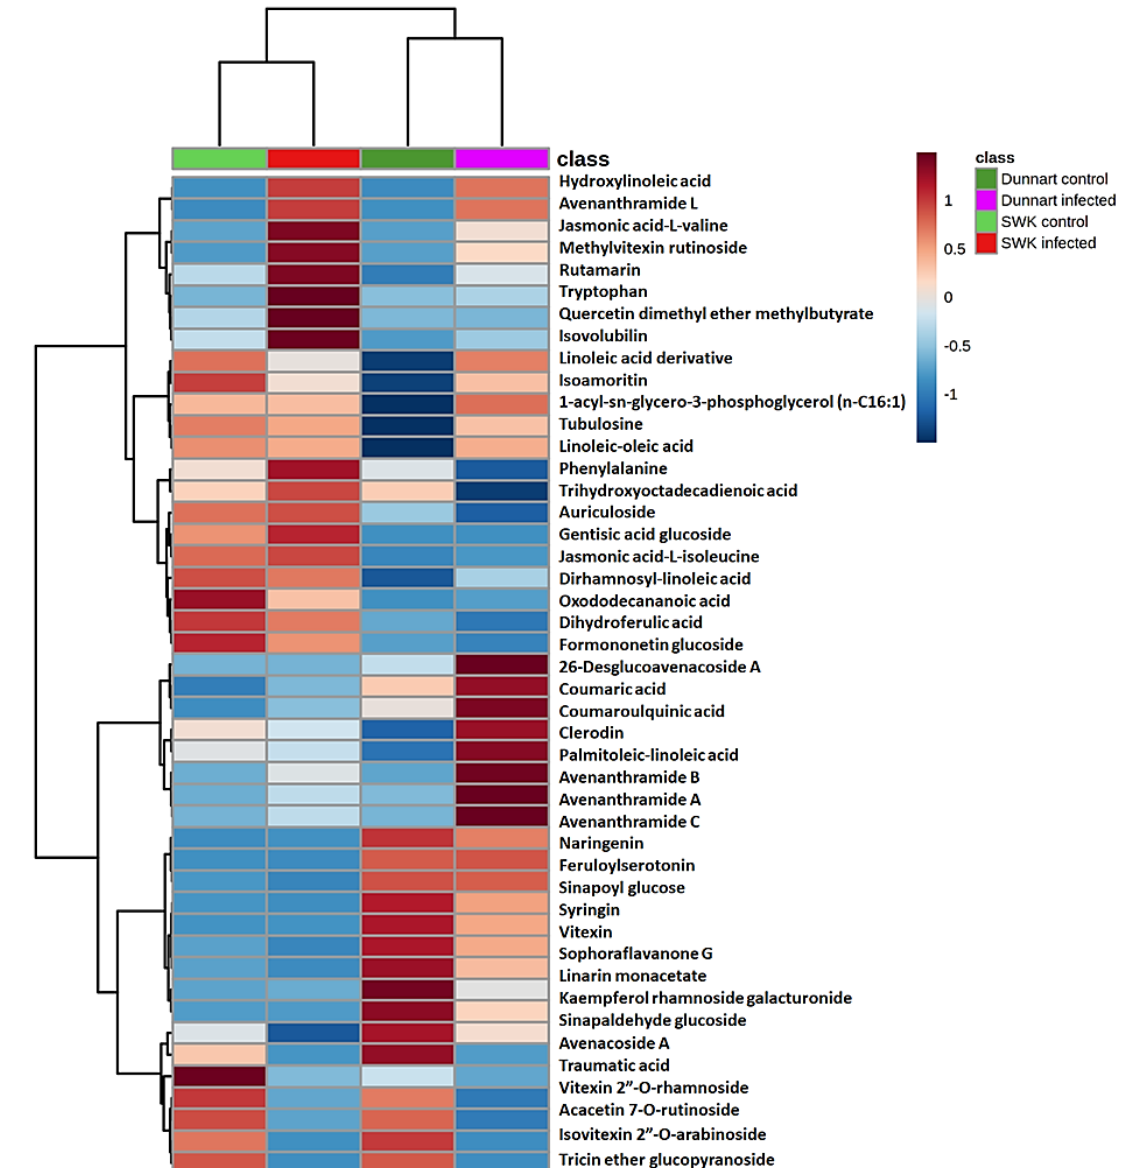
Figure 6. Heatmap analysis of individual peak intensities of the putatively identified discriminatory metabolites from oat leaves treated with Ps-c. The map was constructed (using the Pearson distance and Ward’s linkage rule) to illustrate infected and control groups of the two respective cultivars, “Dunnart” and “SWK001”. After Pareto -scaling the data, the mean peak intensities of each annotated metabolite are displayed. Higher than average values are shown in brown, while lower values are shown in blue, with each row representing discriminant features and each column representing cultivars and treatment groups, respectively.